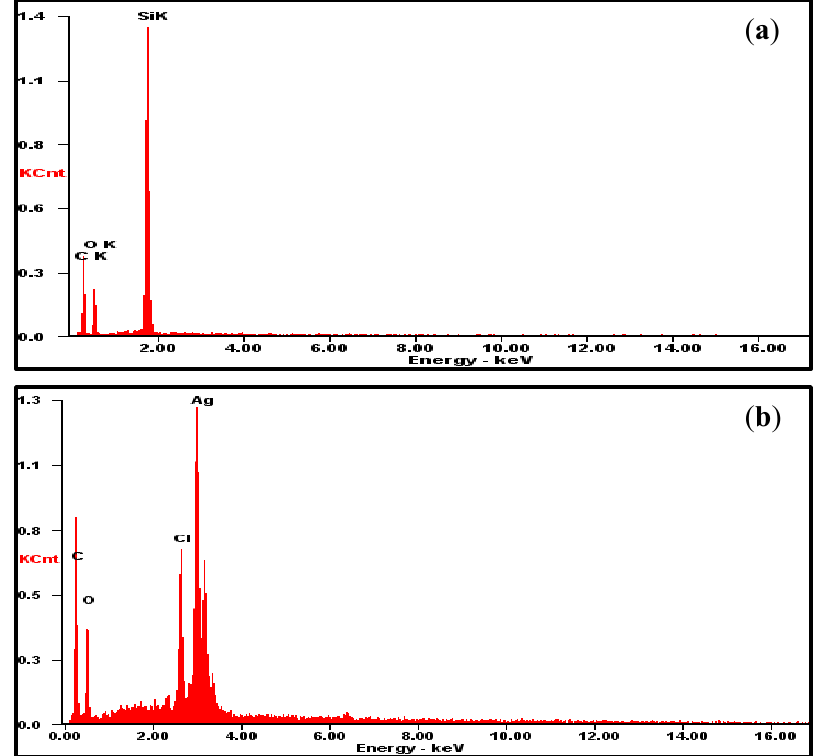
Figure 5. EDS analysis of the electrode surface. ( a ) GO layer formed on a silicon wafer (shown for comparison); ( b ) GO layer on a thin film of